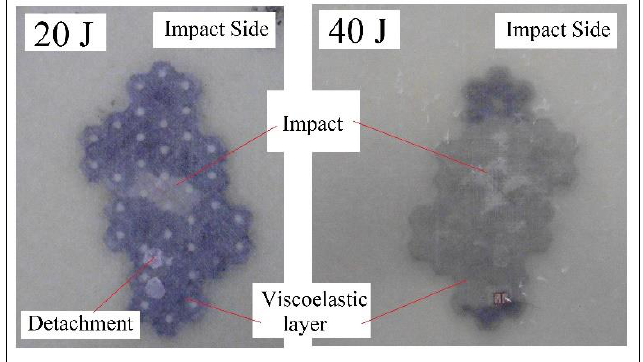
Figure 19. Impact tests for gravity weight drop of 30 and 40 J of energy to modified panels.